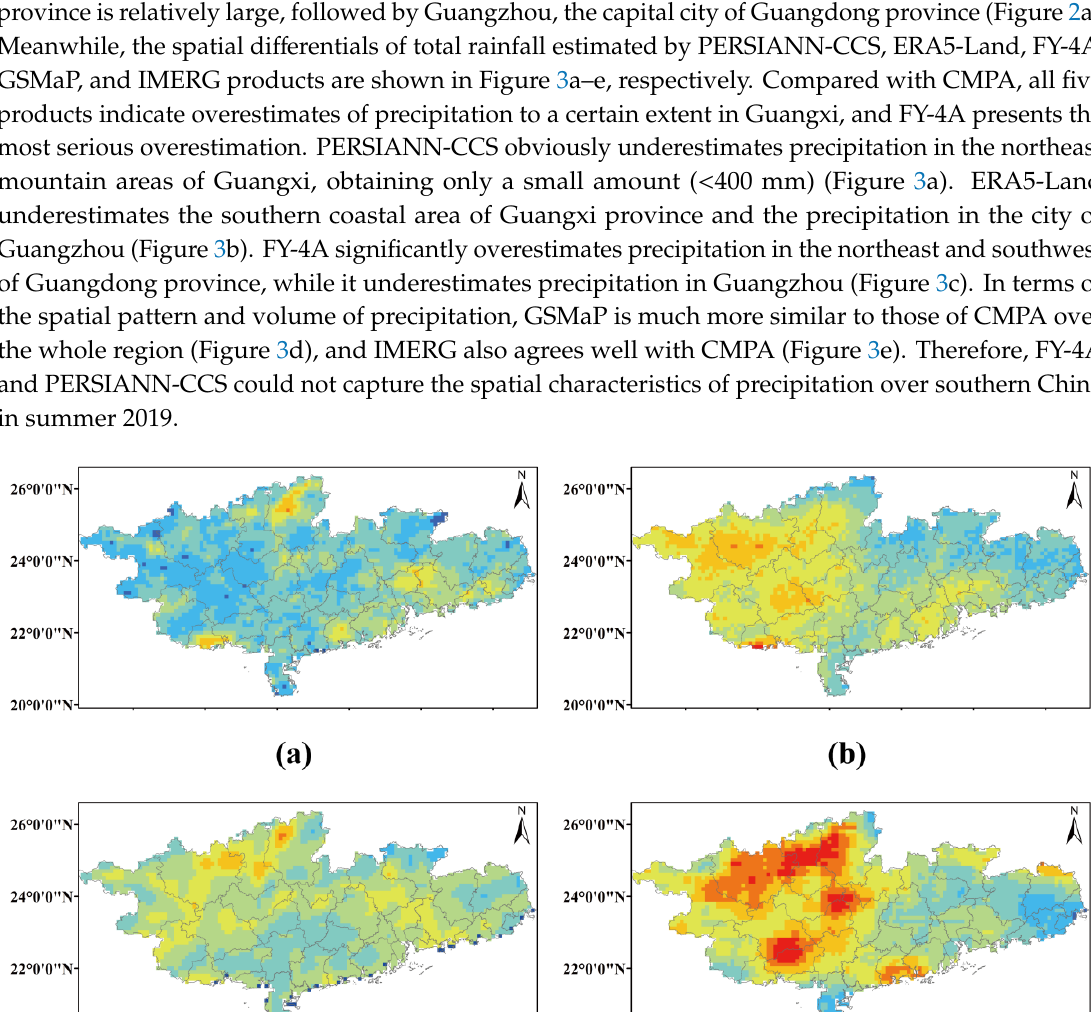
Figure 2. Spatial patterns of accumulated rainfall estimated by ( a ) China Merged Precipitation Analysis (CMPA), ( b ) Precipitation Estimates from Remotely Sensed Information using Artificial Neural Networks Cloud Classification System (PERSIANN-CCS), ( c ) European Center for Medium- Range Weather Forecasts Reanalysis v5 (ERA5-Land), ( d ) Fengyun-4 (FY-4A), ( e ) Global Satellite Mapping of Precipitation (GSMaP) (GSMaP), and ( f ) Multi-satellitE Retrievals for Global Precipitation Measurement (IMERG) over southern China in summer 2019.